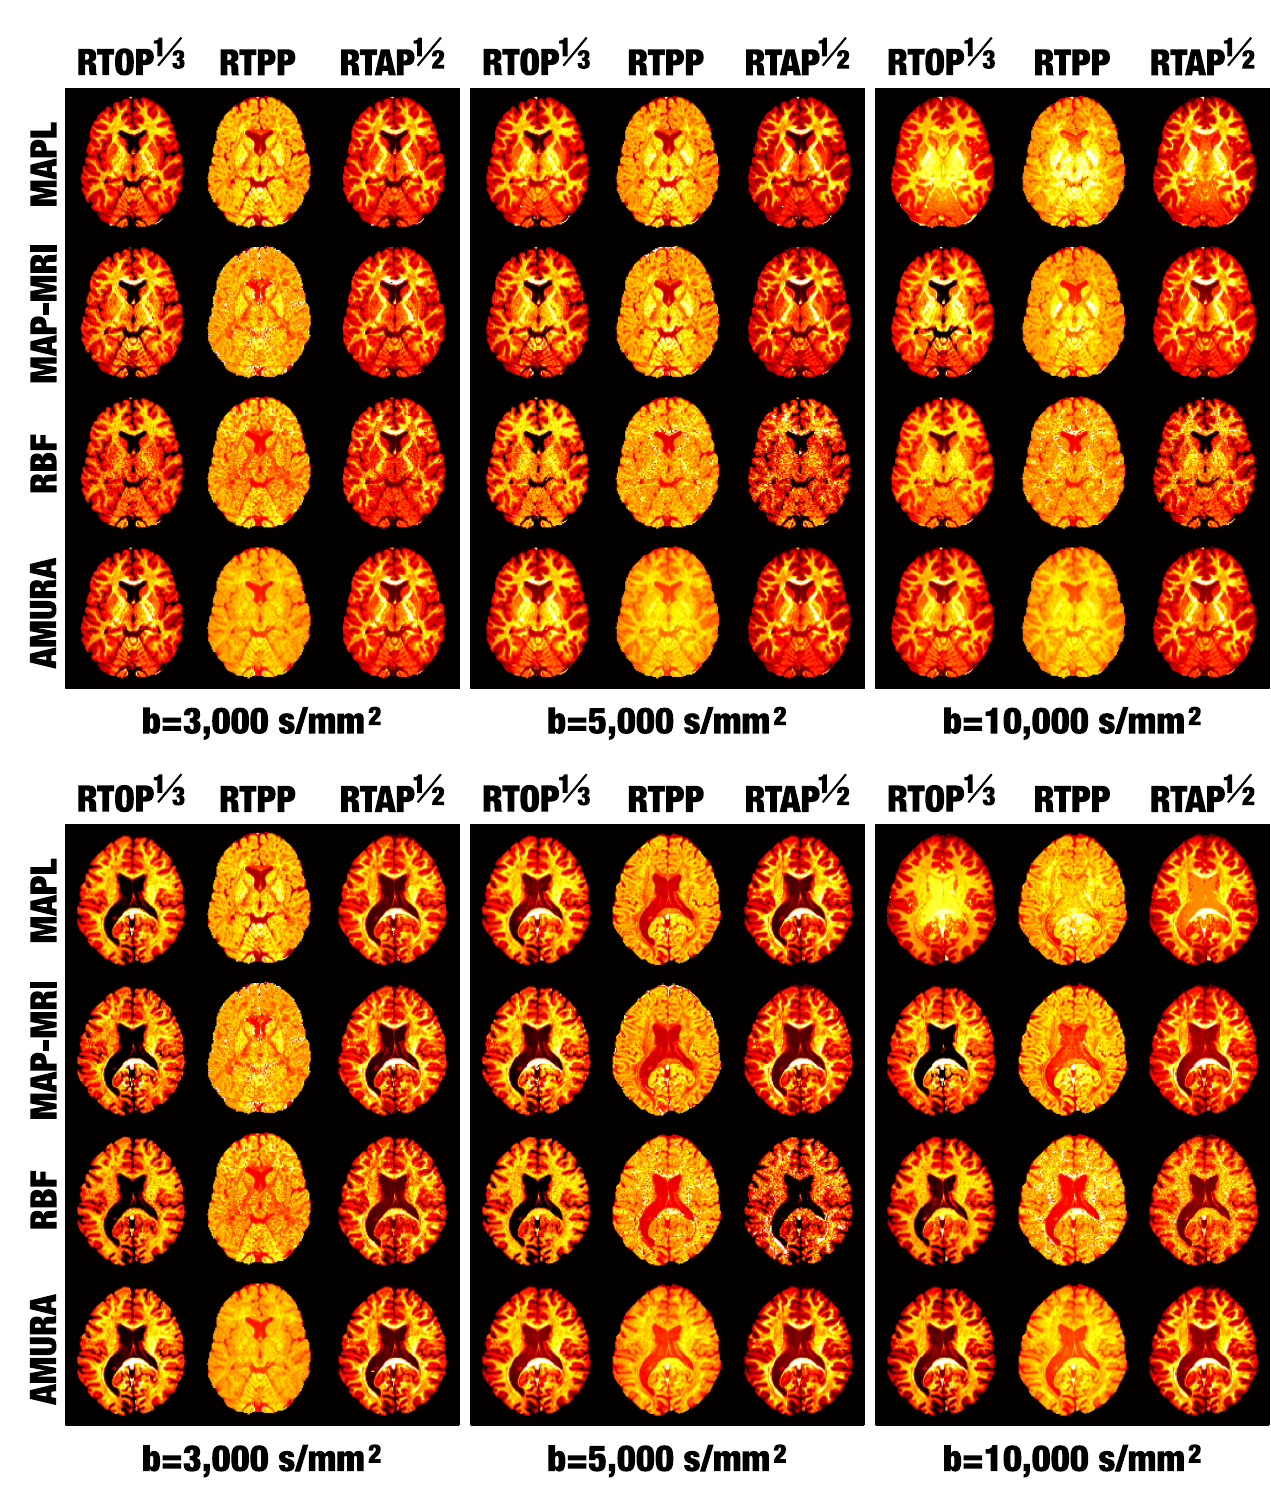
Fig 1. Visual assessment of the consistency of AMURA. (Top) Slice 42 of the MGH1016 volume from HCP; (Bottom) Slice 51 of the MGH1018. AMURA is calculated with one single shell at the specified b-value. MAPL, MAP-MRI and RBF are calculated using either 2 or 3 shells at the maximum b-value specified. For the sake of visual comparison, RTOP and RTAP have been gamma-corrected as specified.